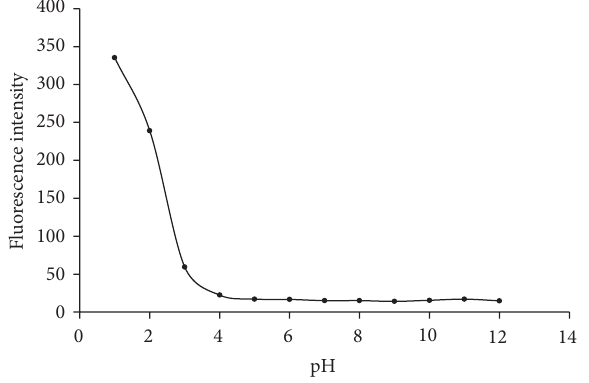
Table 3: Results of standard addition